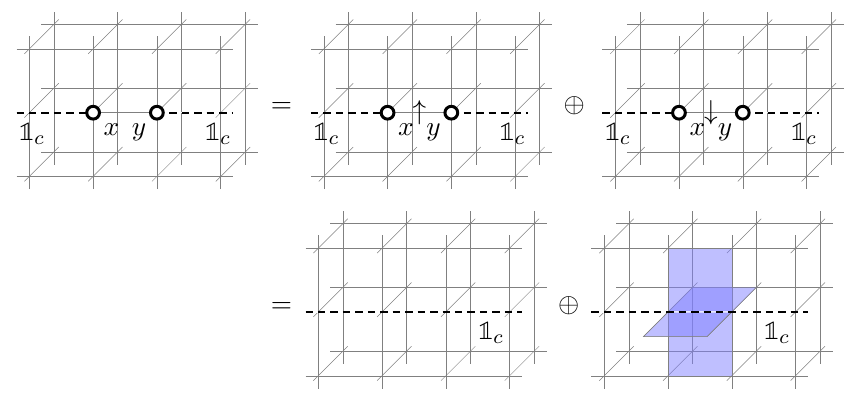
Figure 14. The fusion of an x -particles and a y -particle is x ◦ y = 1 1